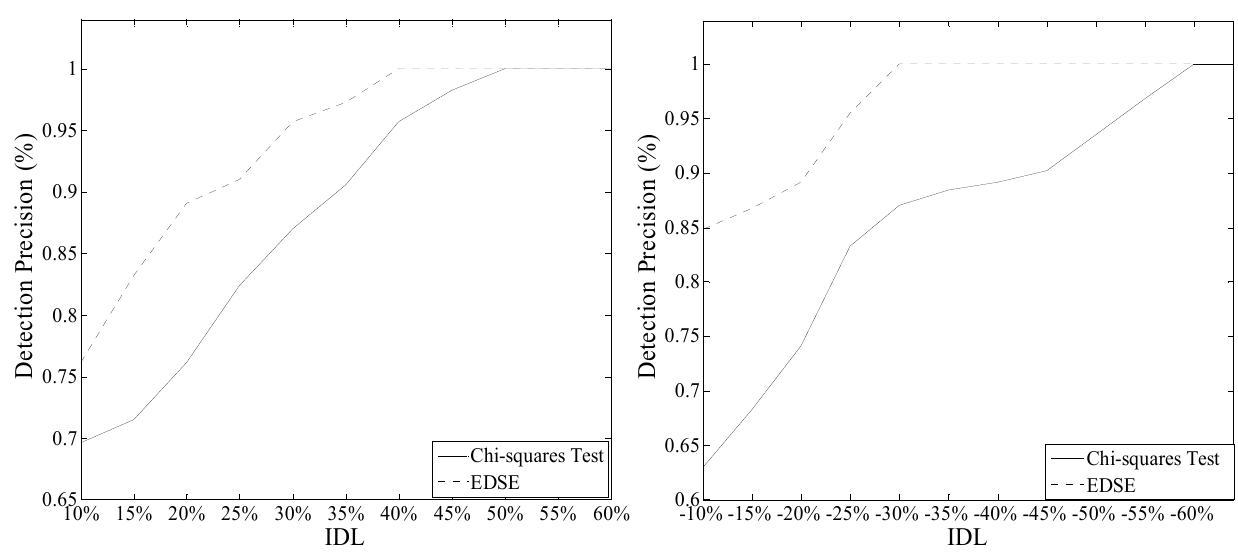
Figure 5. Comparison of detection